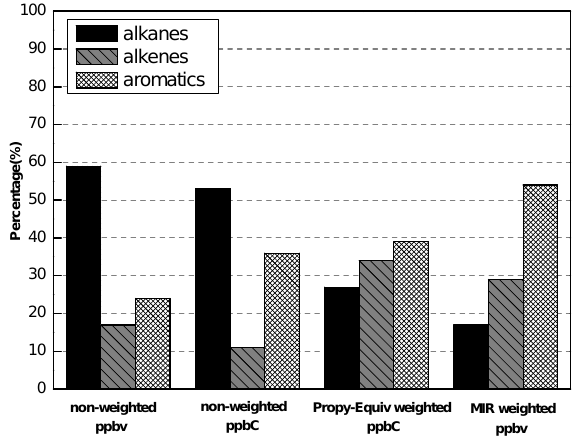
Figure 6. VOC profiles based on different scales from June 2011 to May 2012 at